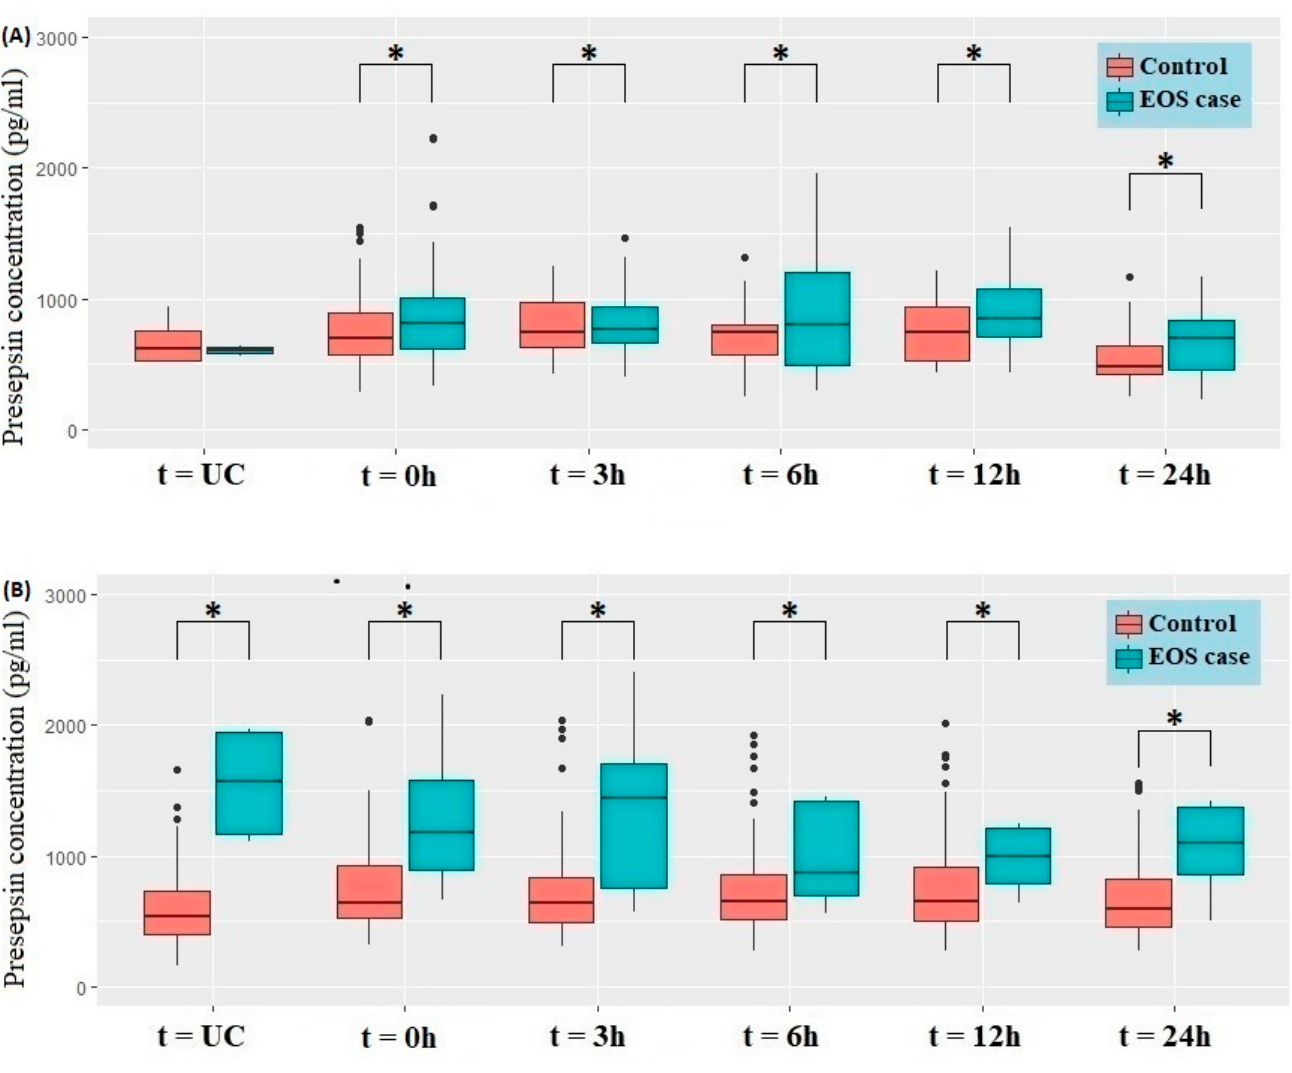
Figure 1. Boxplots of presepsin concentrations (pg/mL) before antibiotic initiation at initial sepsis suspicion (t = 0) and the other time points for early-onset neonatal sepsis cases (blue) and uninfected controls (red) in term-born infants ( A ) and preterm-born infants ( B ). EOS = early-onset sepsis; h = hour; UC = umbilical cord blood. Asterisks indicate a statistically significant difference in presepsin concentration between controls and EOS cases.